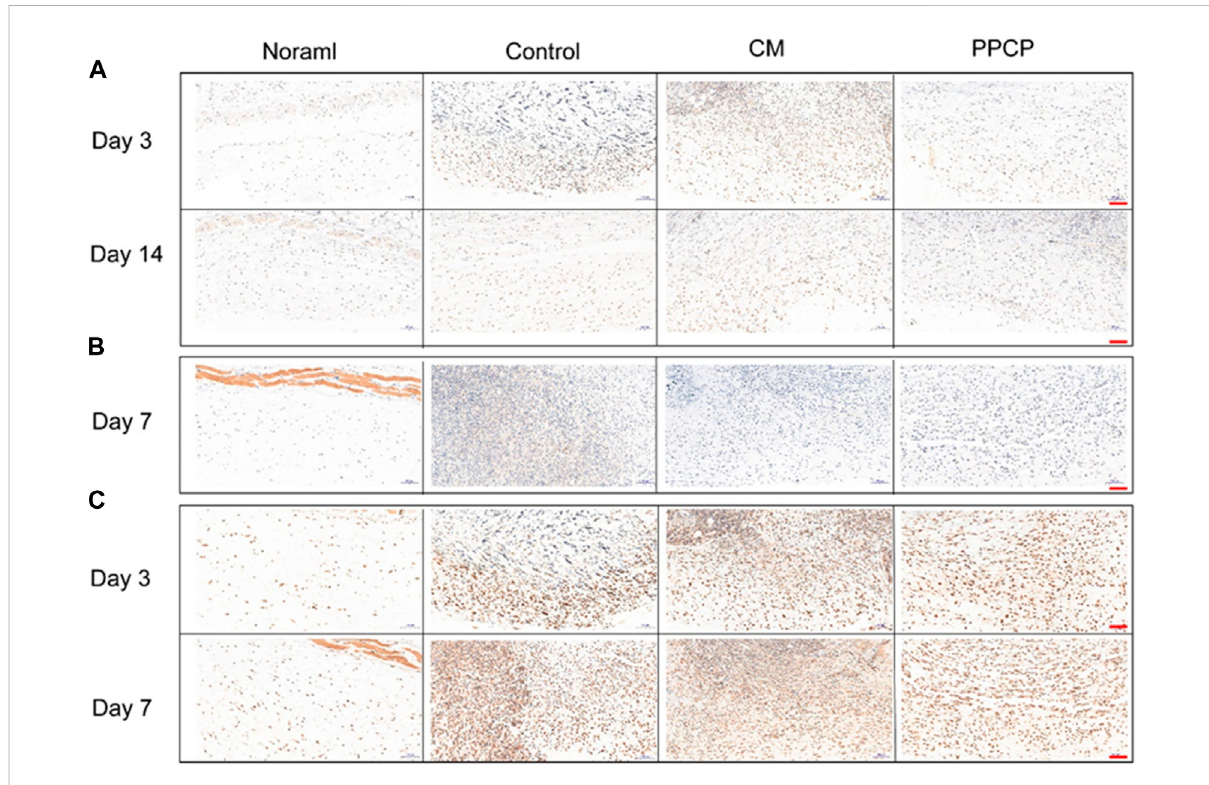
FIGURE 8 Image of tissues stained with Immunohistochemical staining (scale bar represents 100 μ m). (A) Immunostaining of IL-1 β on days 3 and 14; (B) Immunostaining of IL-6 on day 7; (C) Immunostaining of TNF- α on days 3 and